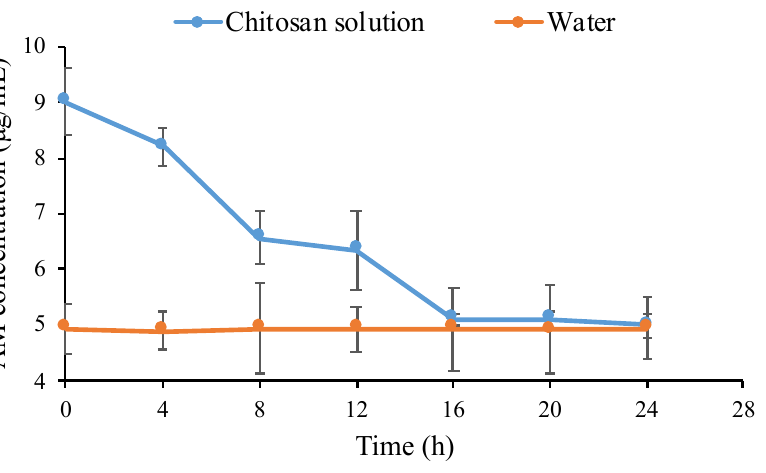
Figure 5. The concentration of AM in the water and WSC solutions ( n = 3, mean ± standard deviation). The nucleation induction time was evaluated at the beginning of measurement at intervals of 1, 5, 10, 15, and 30 min, as shown in Figure 6, to determine the ability of chitosan to inhibit AM crystal nucleation. The result showed that chitosan maintained the initial supersaturation level of AM for 30 min, indicating the inhibitory effect of WSC on AM crystal. The objective of the present study was to clarify the impact of WSC on the growth and nucleation of AM from supersaturated solutions. Based on these data, it was observed that the WSC solution could effectively hinder the crystal growth and reduce nucleation of AM; thus, elevated levels of supersaturation could be maintained for extended periods of time. Polymeric additives have been widely utilized in supersaturated formulations because of their ability to inhibit drug crystallization [10]. It has been reported that polymers stabilize drugs in supersaturated solutions by intermolecular interactions between drugs and polymers, thus inhibiting drug crystal nucleation in the long term [12]. Therefore, WSC could be a potential polymer that maintained levels of AM supersaturation after dissolving in the water.